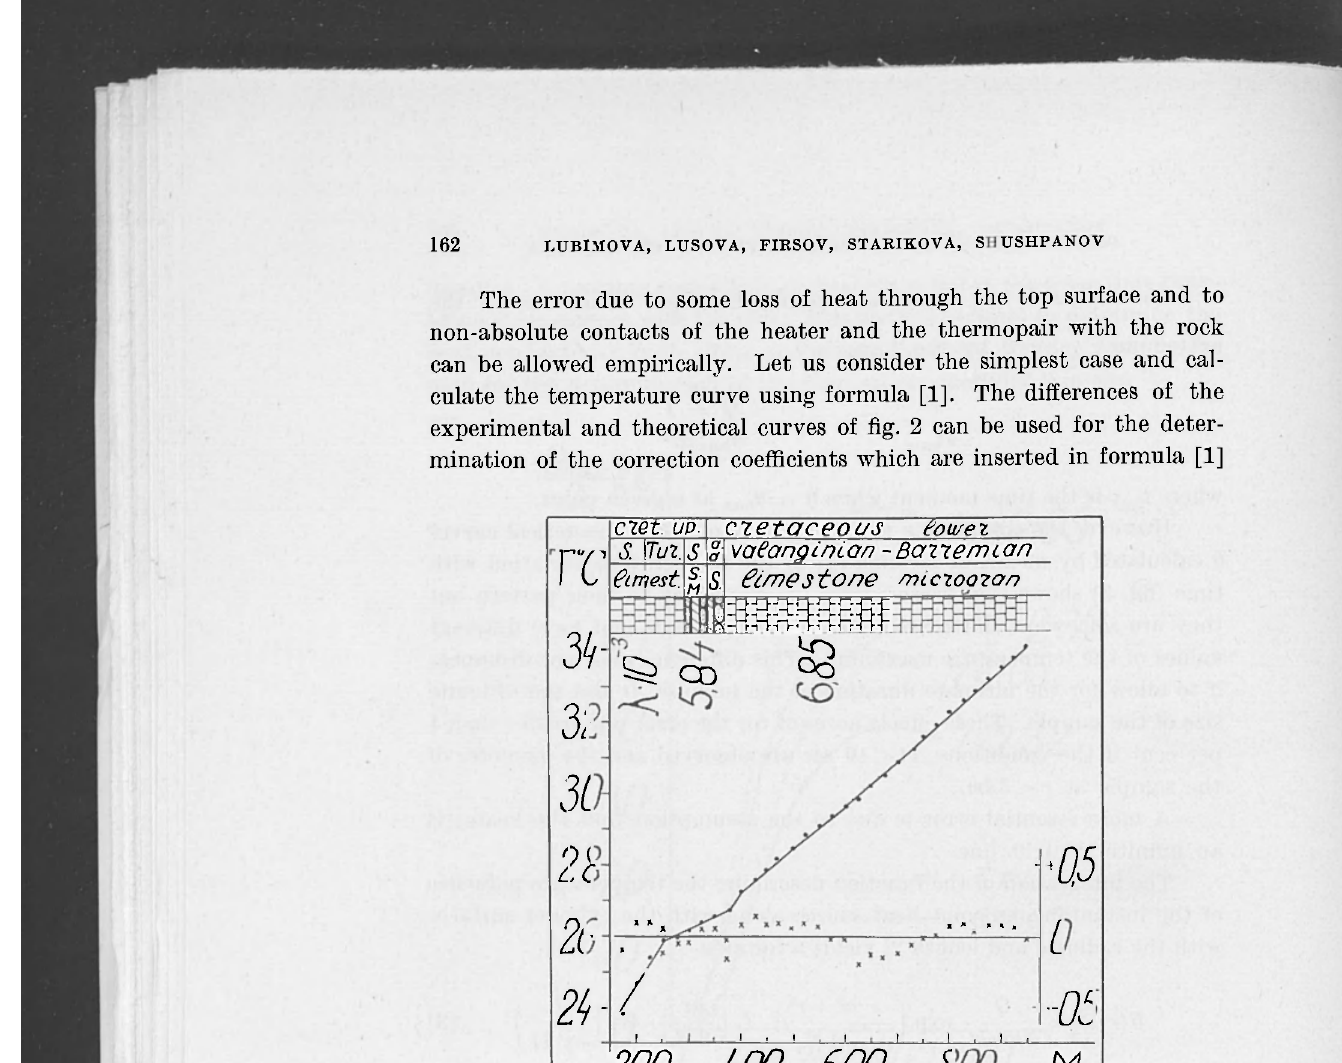
Fig. 4 - Lithological and stratigraphioal cross-section of the bore-hole 3T Old